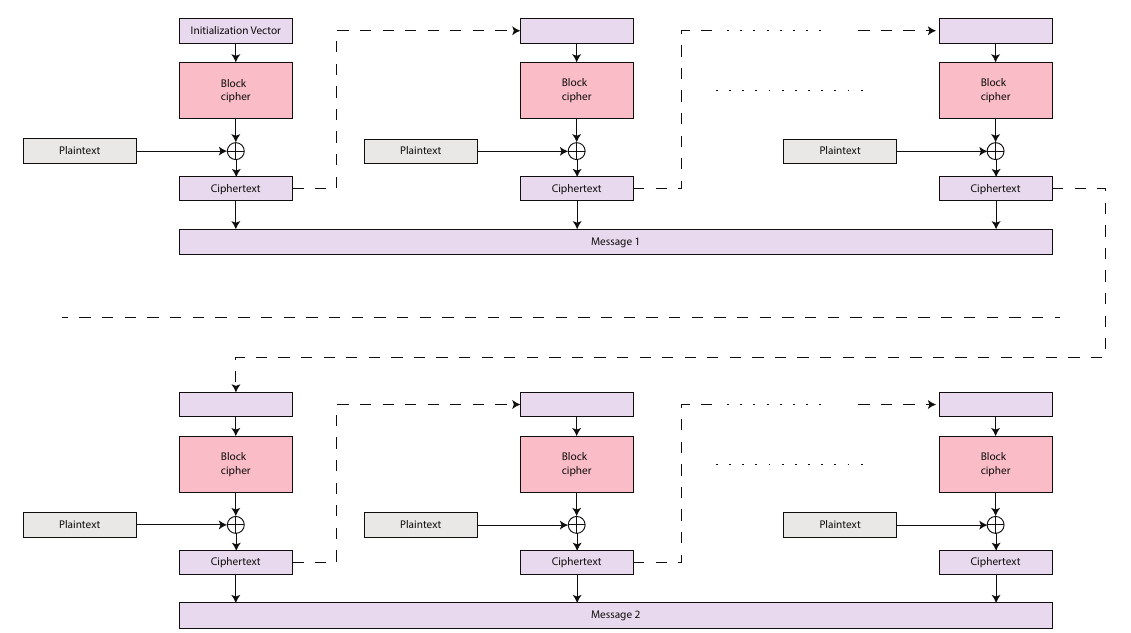
Figure 6: A block cipher operated in CFB mode, with a carry-over